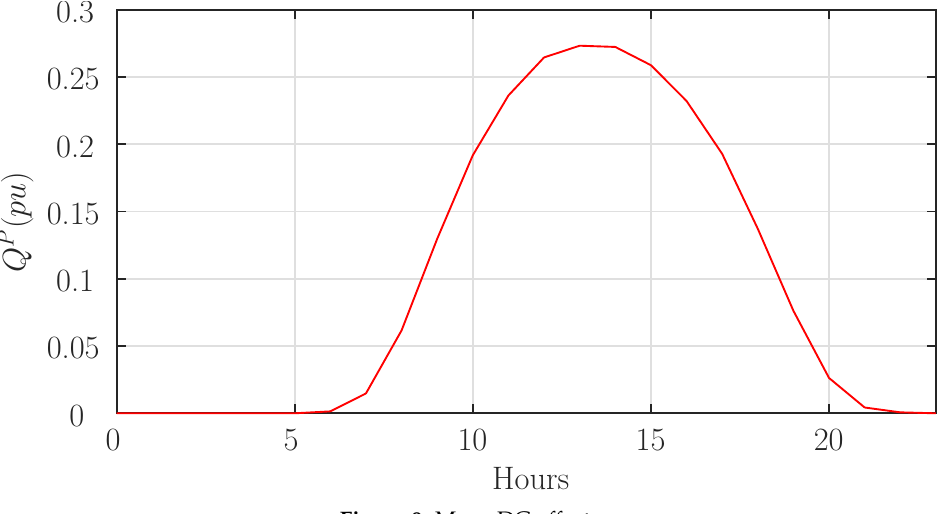
Figure 9. Mean DG